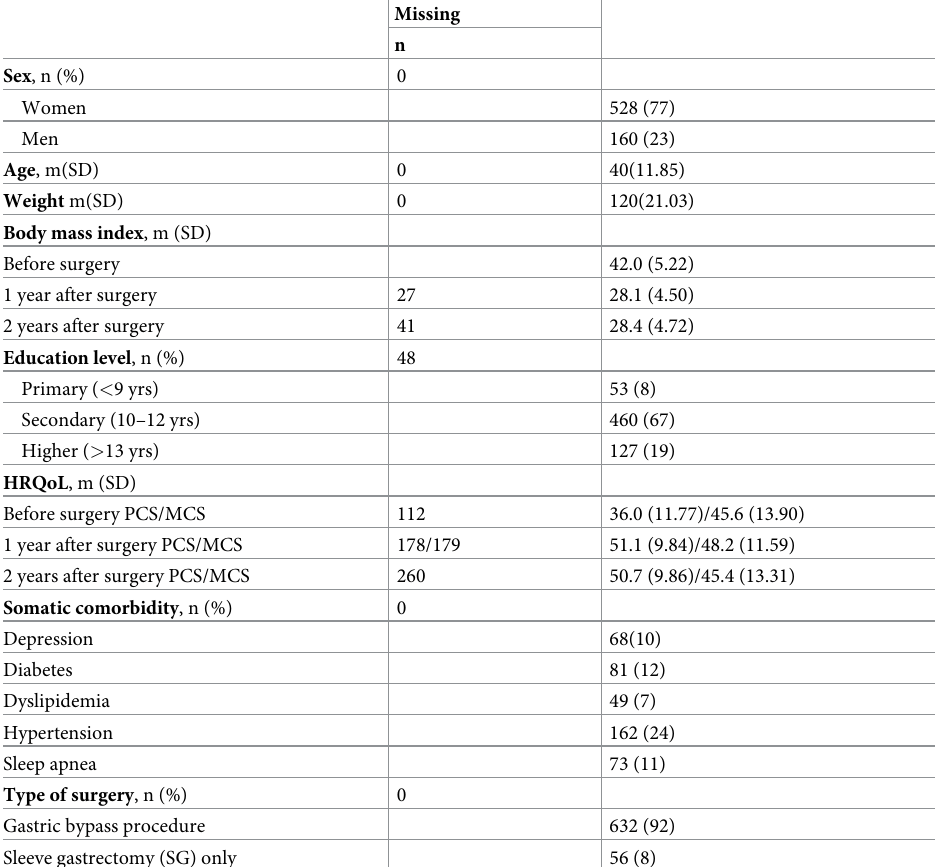
Table 1. Participant characteristics and